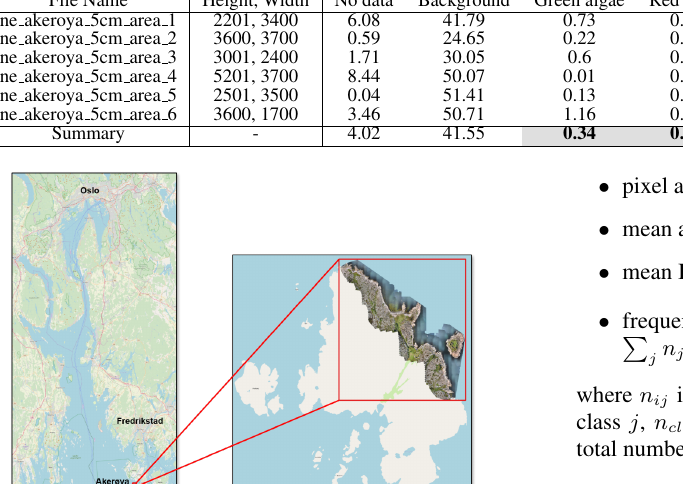
Table 1. Ground truth statistics. The numbers indicate class percentages (%), with minority classes highlight. File Name